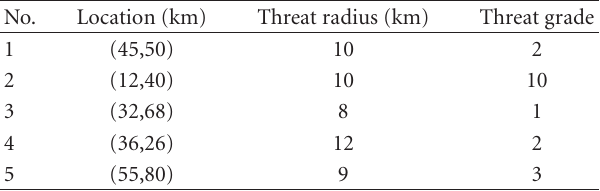
Table 1: Information about known